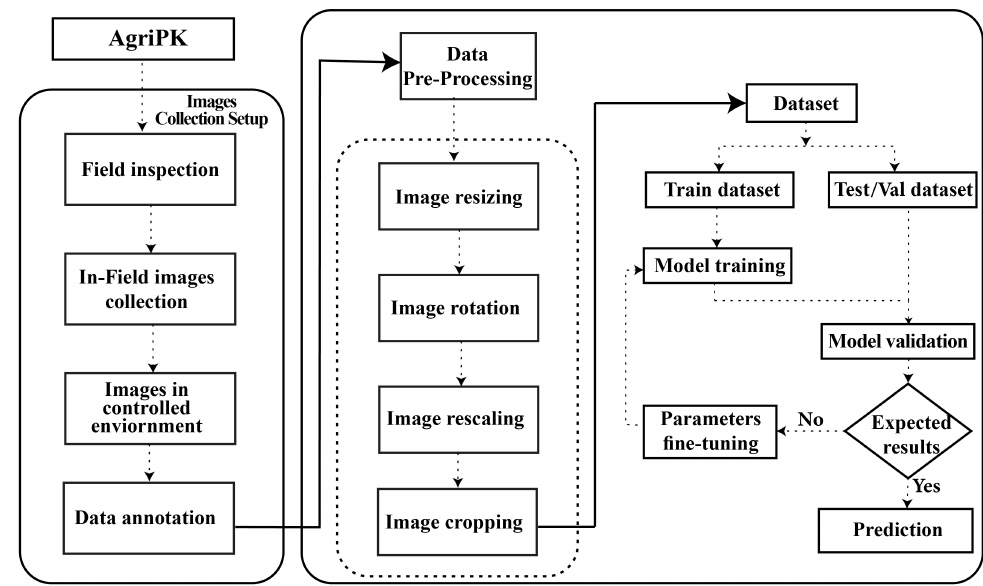
Figure 3. Work flow diagram of proposed